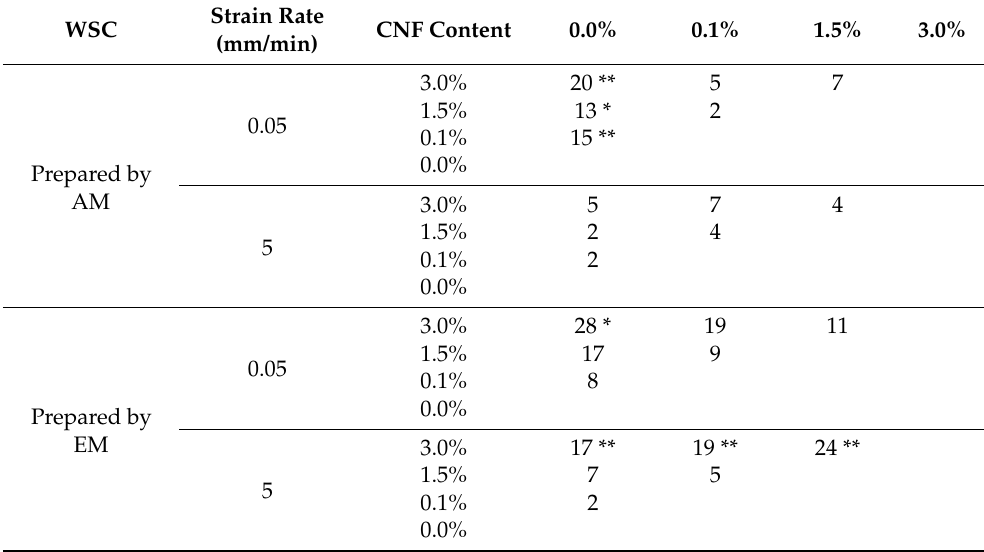
Table 3. Influence of CNF on all-cellulose nanocomposite mechanical